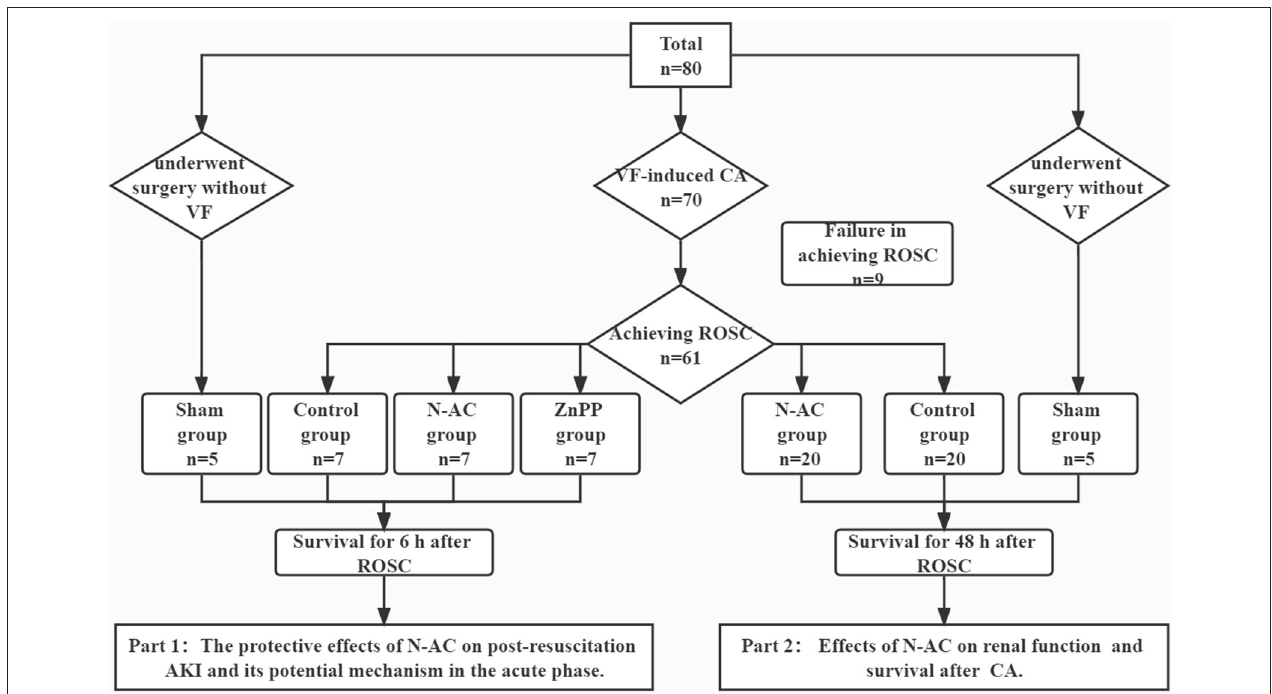
FIGURE 1 | Flow diagram of the study. The whole study is consisted of 2 parts. VF, ventricular fibrillation; CA, cardiac arrest. N-AC, N- N-acetylcysteine; ROSC, return of spontaneous circulation; AKI, acute kidney injury.